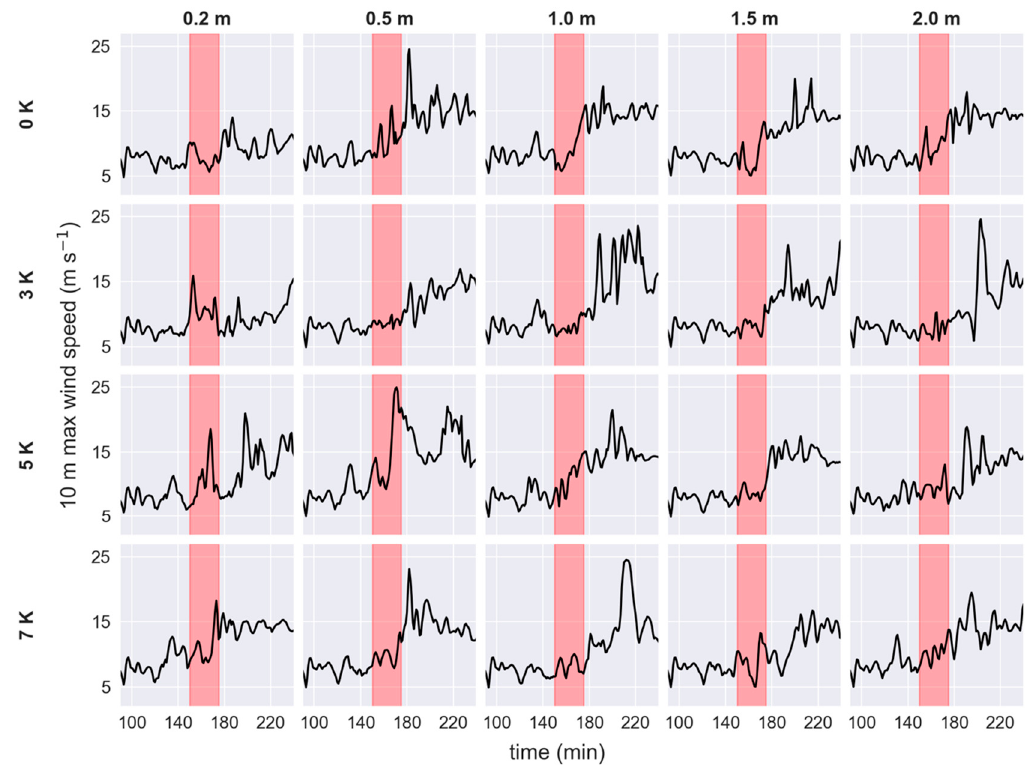
Figure 19. Time-series of 10-m wind speed. The red rectangle highlights the time period when the storm is passing over the idealized city.